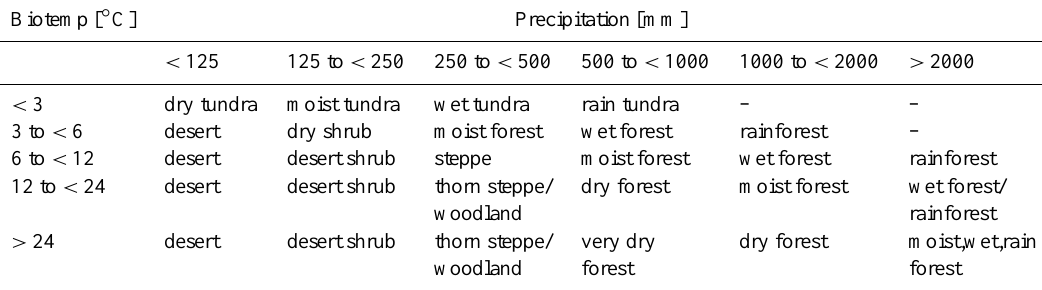
Table 2. Ecosystem classification following Holdridge